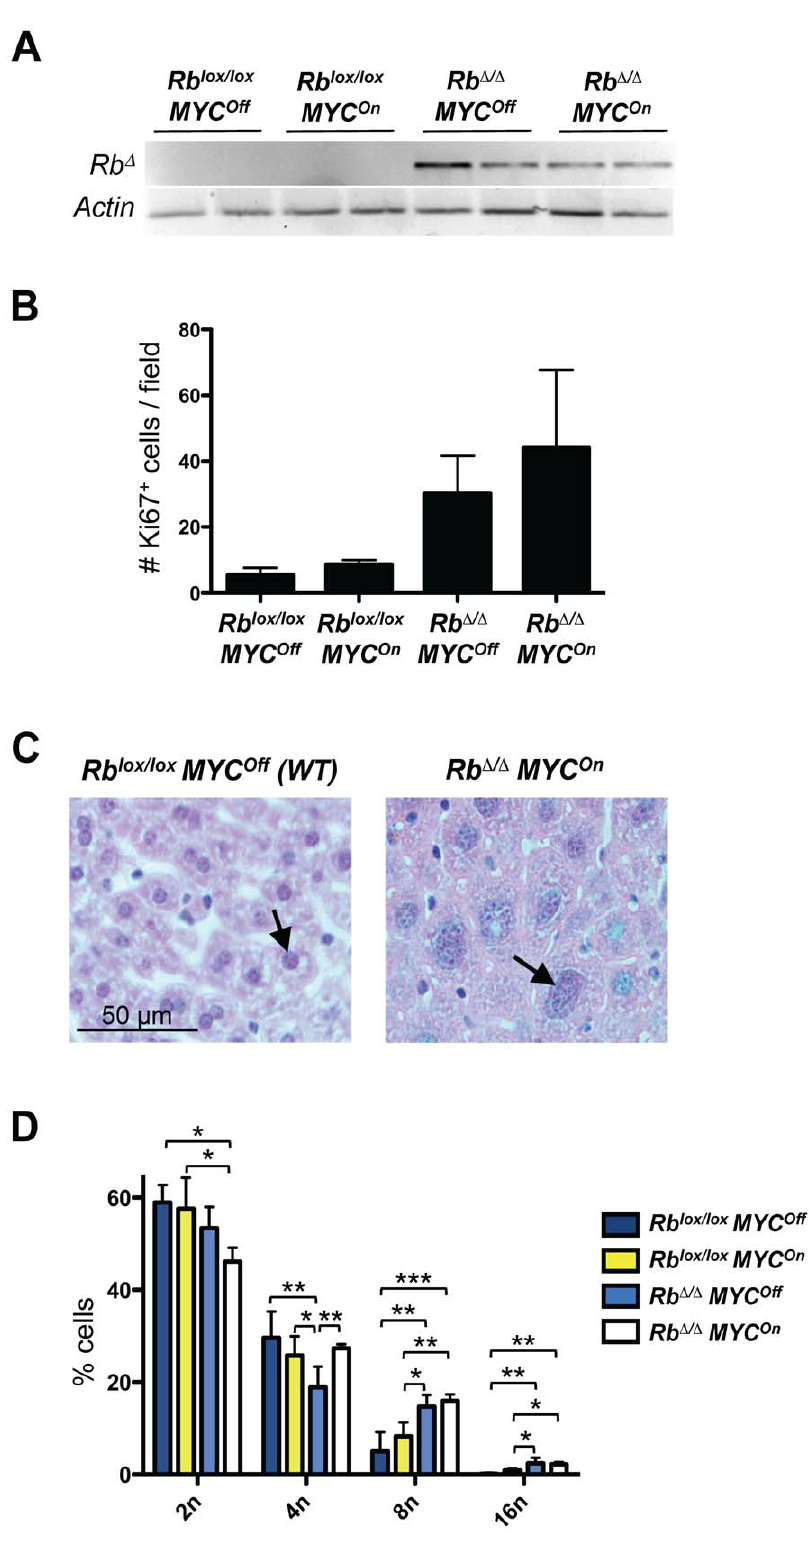
Figure 5. Rb inactivation and MYC activation cooperate to increase ploidy in hepatocytes. A. Genomic PCR analysis for the deleted allele of Rb ( Rb D ) using DNA from control, MYC , Rb , and MYC/Rb mutant livers before the development of tumors in Rosa26 + /CreER mice. Actin serves as a positive PCR control. B. Quantification of immunostaining experiments for the number of Ki67 + liver cells per field on control, MYC , Rb , and MYC/Rb mutant liver sections 5 weeks after the deletion of Rb and the induction of MYC . The number of positive cells in eight 20 6 fields was counted in 2 mice for each treatment group. The differences observed are not significant in a t-test. C. Representative microphotographs of hepatocytes from a mouse injected with corn oil alone in the presence of doxycycline (wild-type for RB and MYC) and a mouse injected with tamoxifen in the absence of